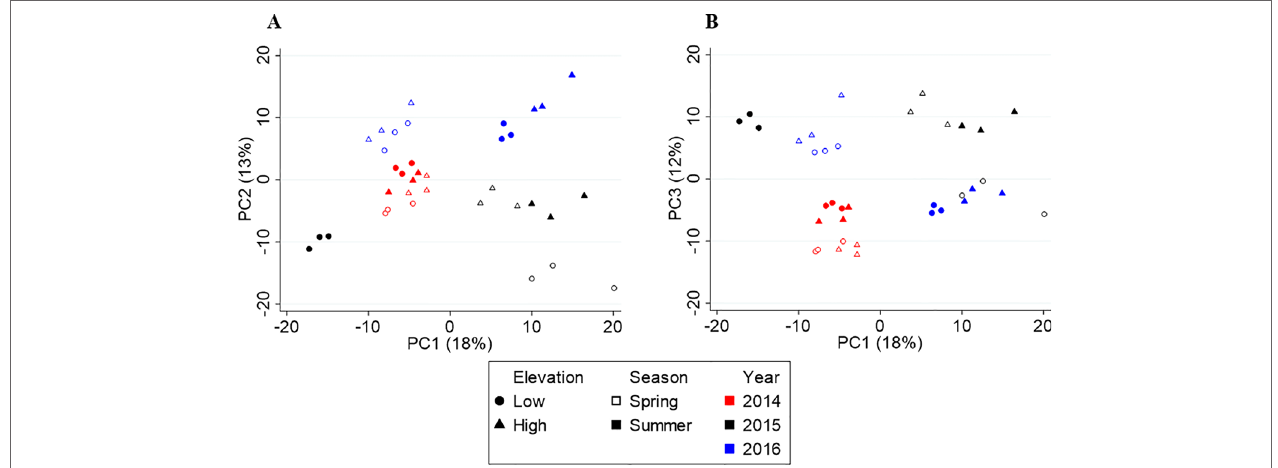
FIgURE 4 | Principal component analysis (PCA) score plots of Fujian tea. (a) PC1 vs. PC2. (B) PC1 vs.